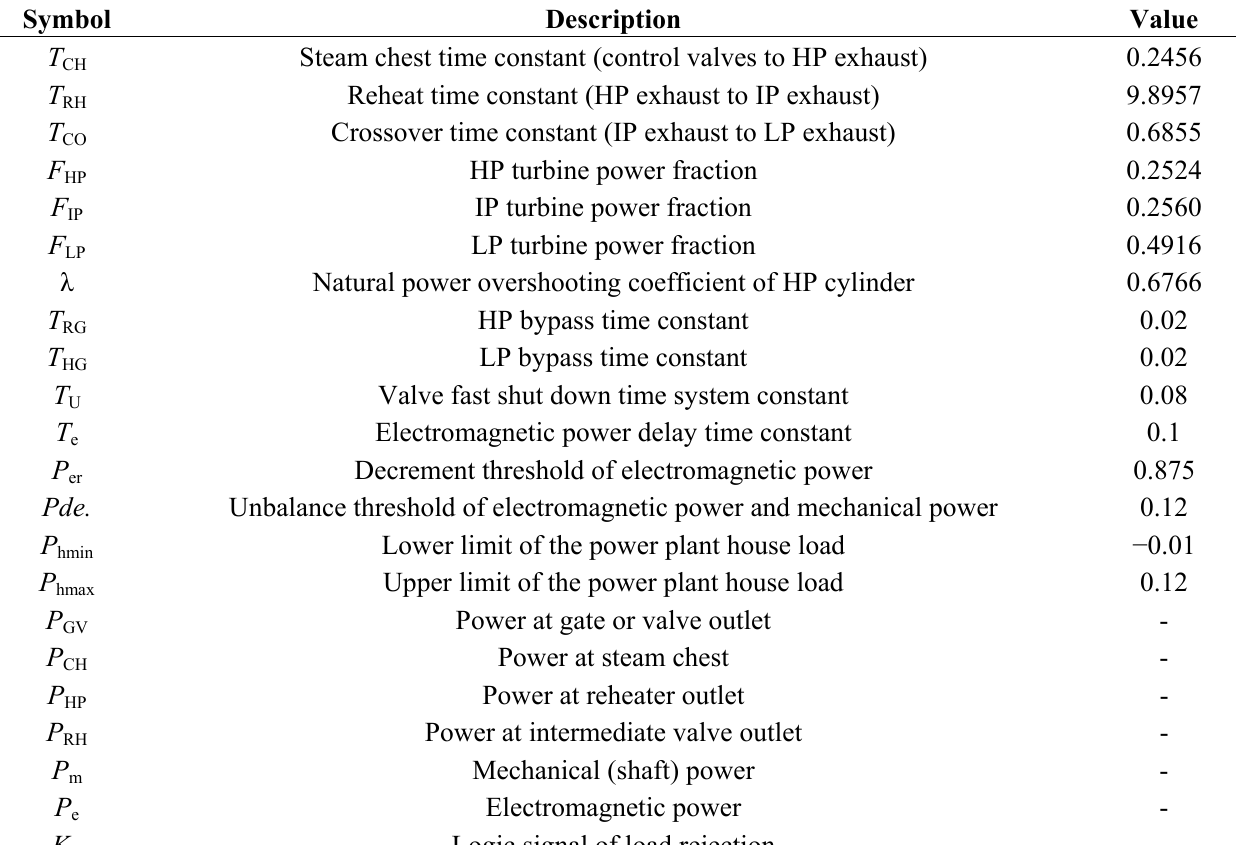
Table A1. Steam turbine model symbols in Figures